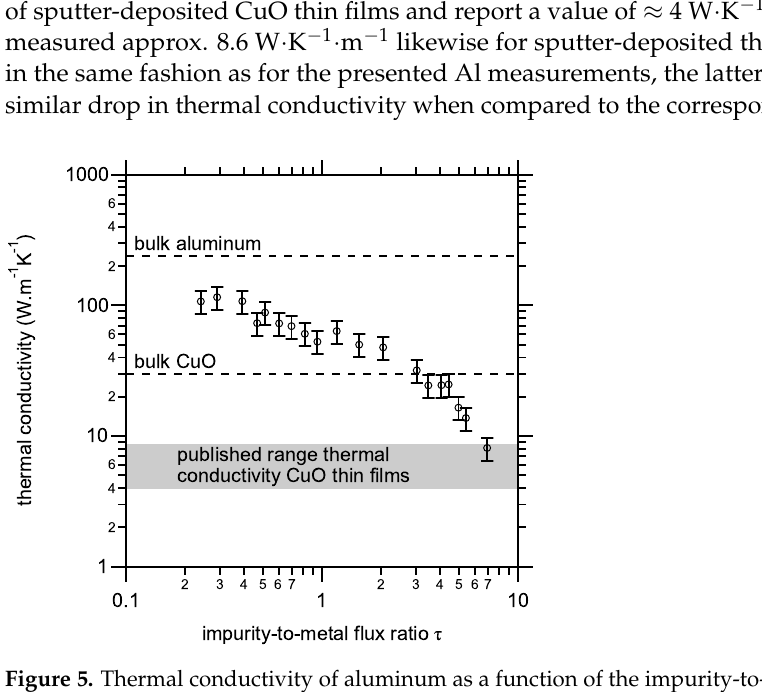
Figure 5. Thermal conductivity of aluminum as a function of the impurity-to-metal flux ratio τ . The thermal conductivity was calculated based on the Wiedemann–Franz law from four-probe resistivity measurements. The indicated range is based on the data by Hartung et al. [42] and Kusiak et al.